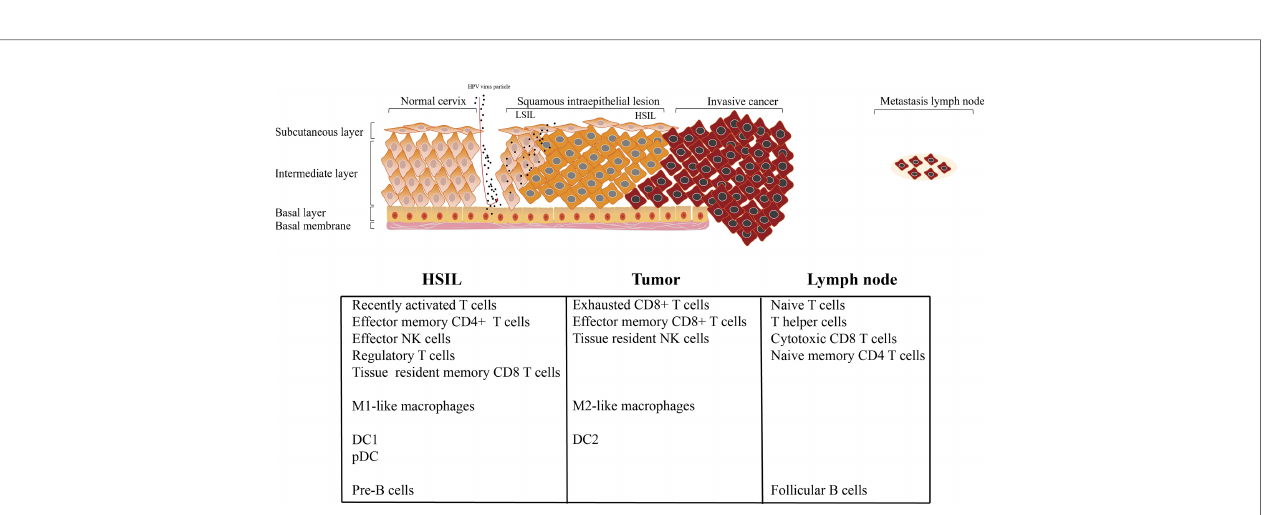
FIGURE 8 | Summary of conclusion.